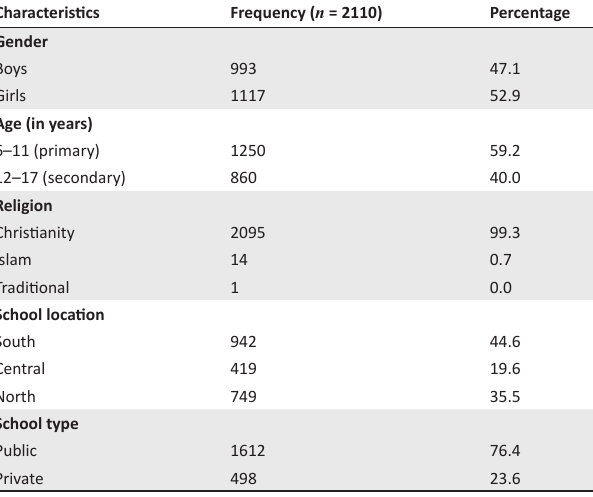
TABLE 1: Demographic characteristics and description of school children in the study.